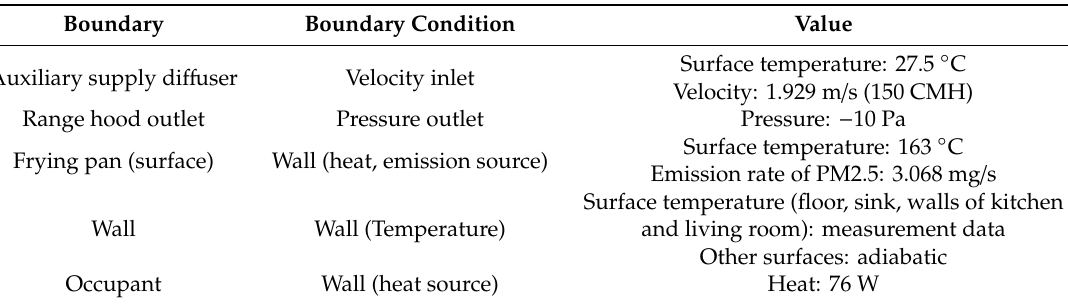
Table 1. Boundary conditions for CFD